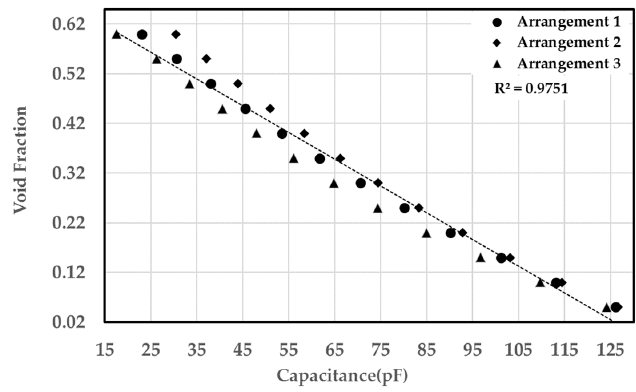
Figure 16. Electric field contour for the distribution of elliptical bubbles.